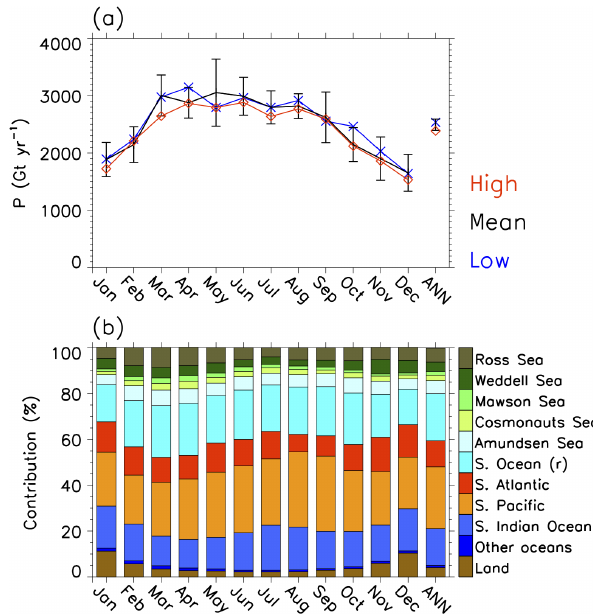
Figure 5. Seasonal variation (January–December) and annual mean (ANN) precipitation over Antarctica in the three simula- tions (a) and the corresponding fractional contributions by the tagged source regions from the mean (b) . Error bars represent 1 standard deviation of corresponding results from 10 individual years of the mean case. Note that the Southern Ocean ( r ) tag plus the five sub-sector tags represents the entire Southern Ocean. Con- tributions from tropical oceans and Northern Hemisphere oceans are combined into “Other